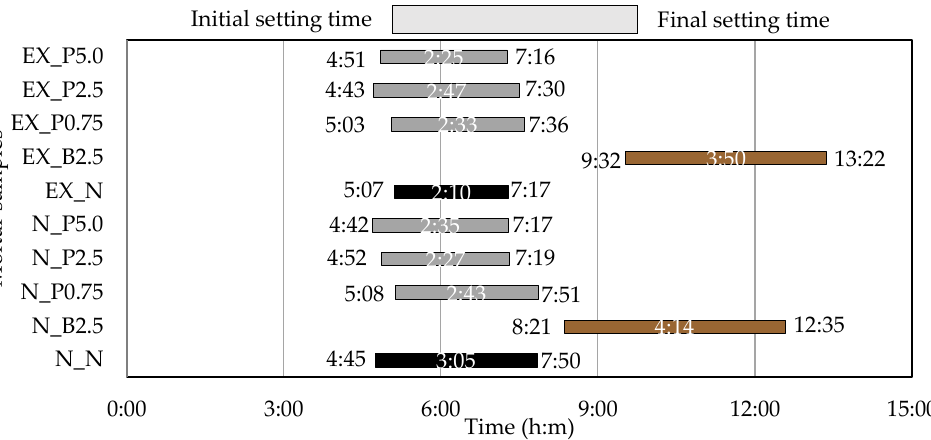
7 of 16 Figure 4. Air content in the fresh mortar. (black: without NFBC, brown: with NFBC type B f , grey: with NFBC type P f ) 3.2. Setting Time Figure 5 shows the setting time in the mortar. As compared with N_N and EX_N, the initial setting time and the final setting time were delayed by adding Bf, and the duration was lengthened. This is considered to be the effect of the sugar contained in Bf (contained